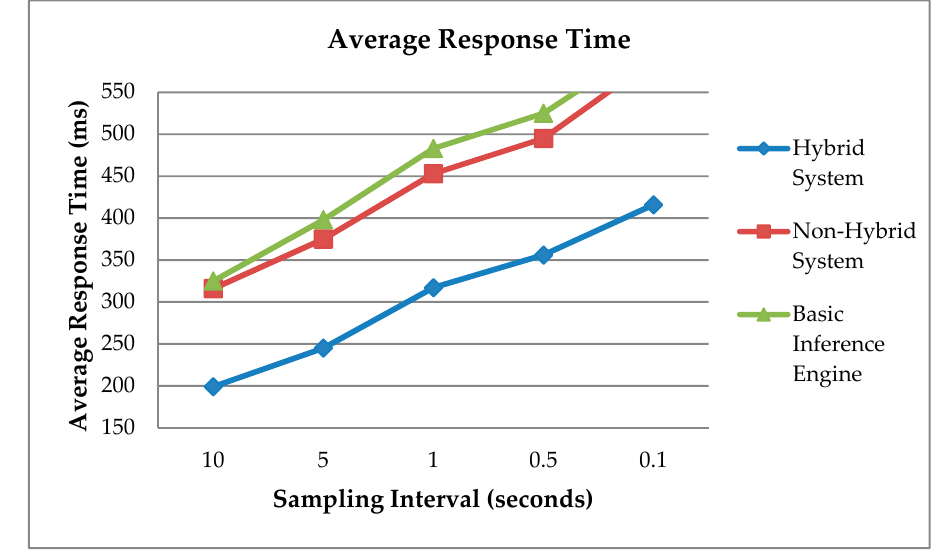
Figure 17. Average response time.